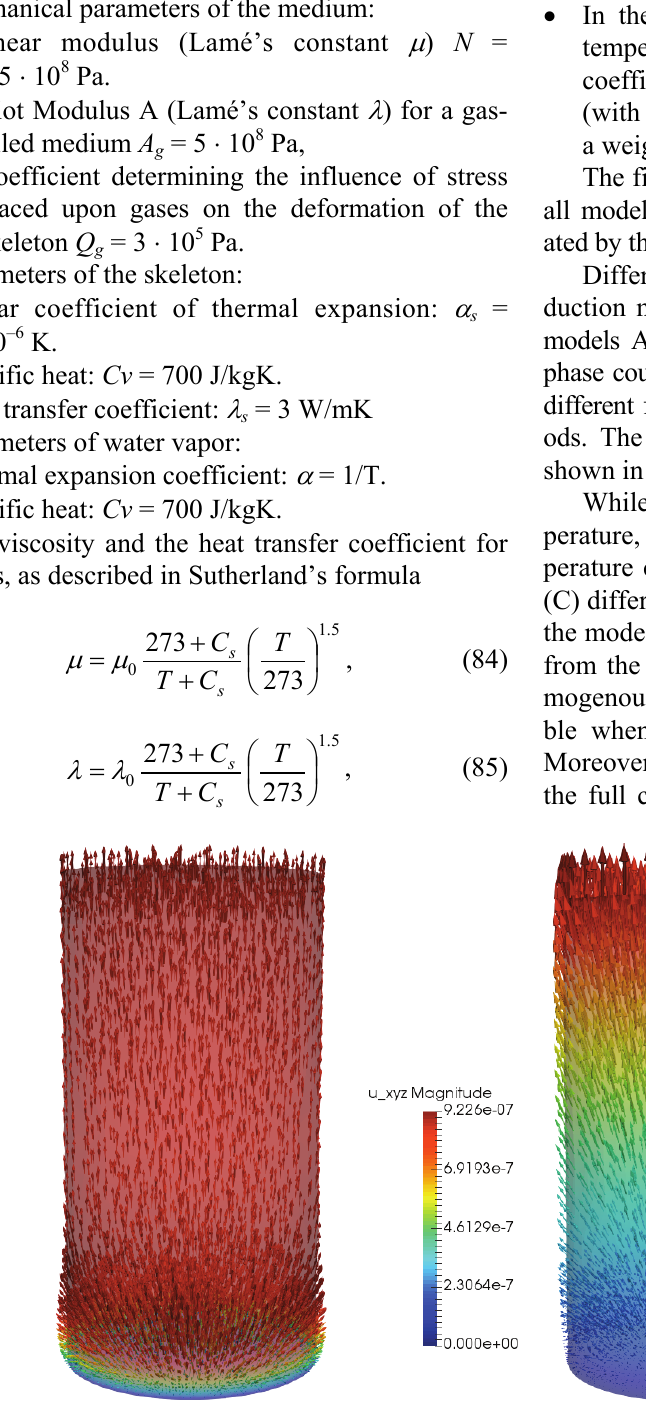
Fig. 2. Displacement: a) after 120 s, b) after 8000